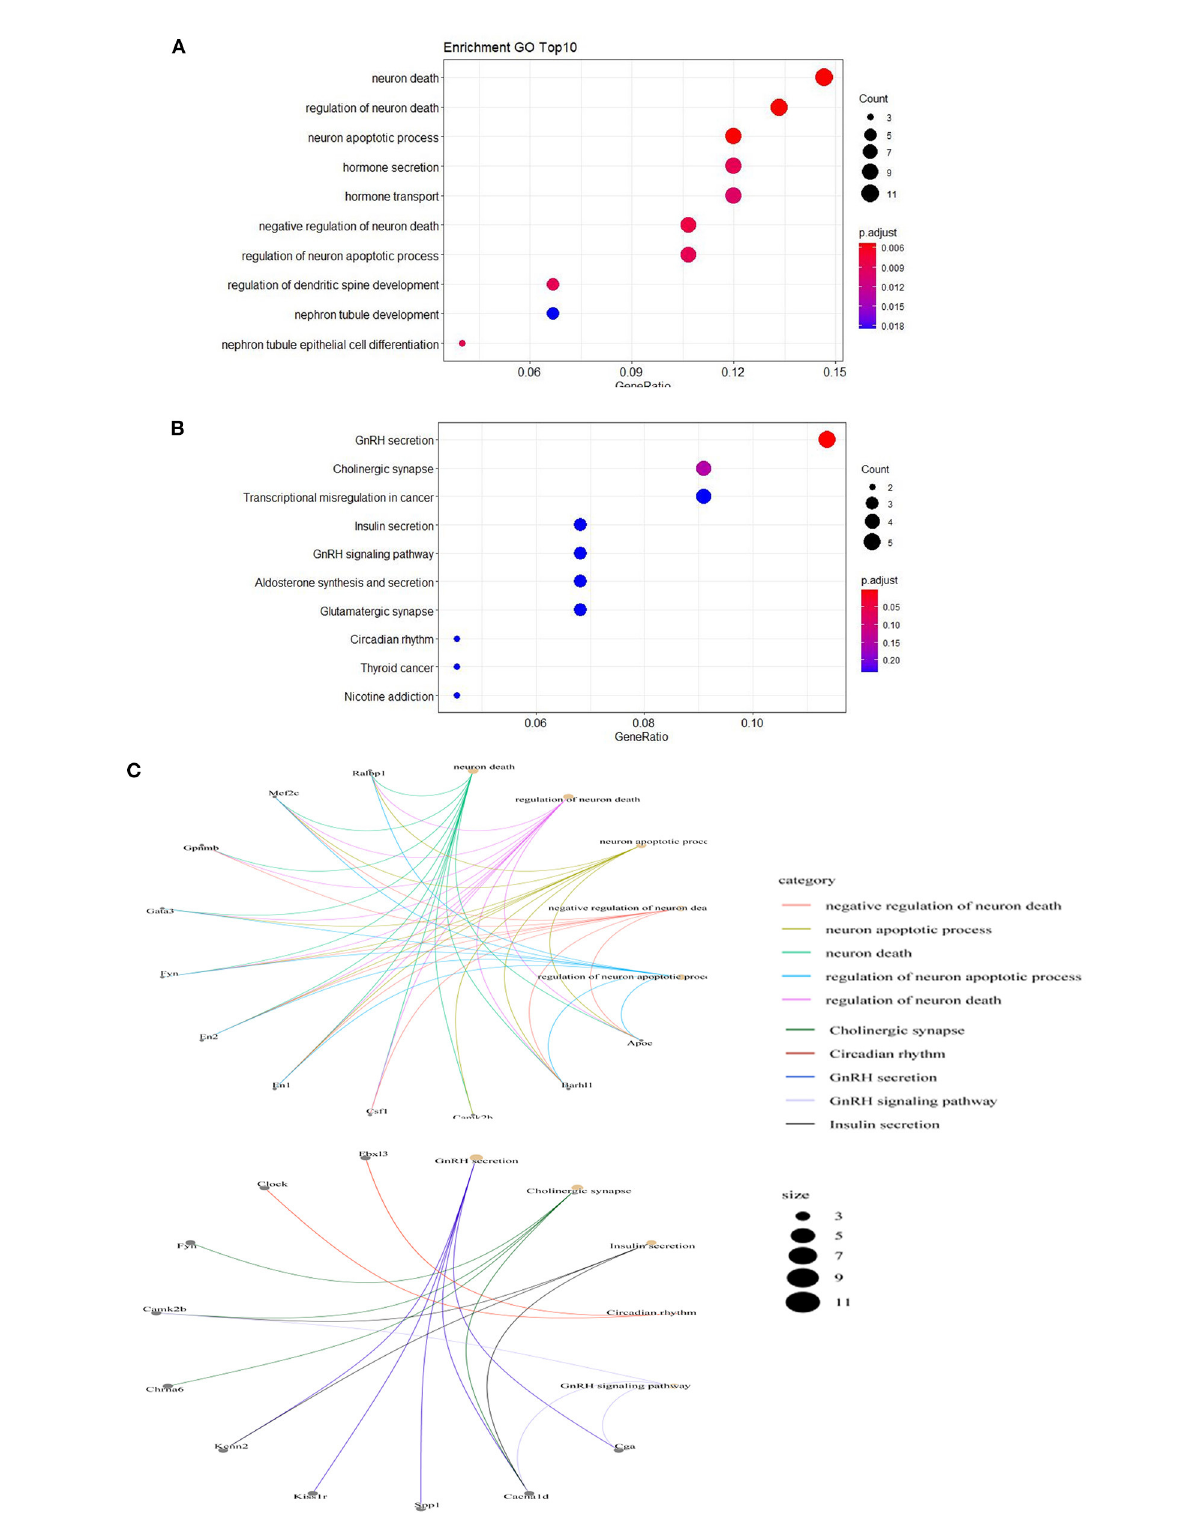
FIGURE3 Gene Ontology annotation and Kyoto Encyclopedia of Genes and Genomes pathway analysis of differentially expressed mRNAs. (A) Top 10 Gene Ontology Annotation P < 0.05. (B) Top 10 Kyoto Encyclopedia of Genes and Genomes pathways P < 0.05. (C) The network diagram of relationship between enrichment function and gene